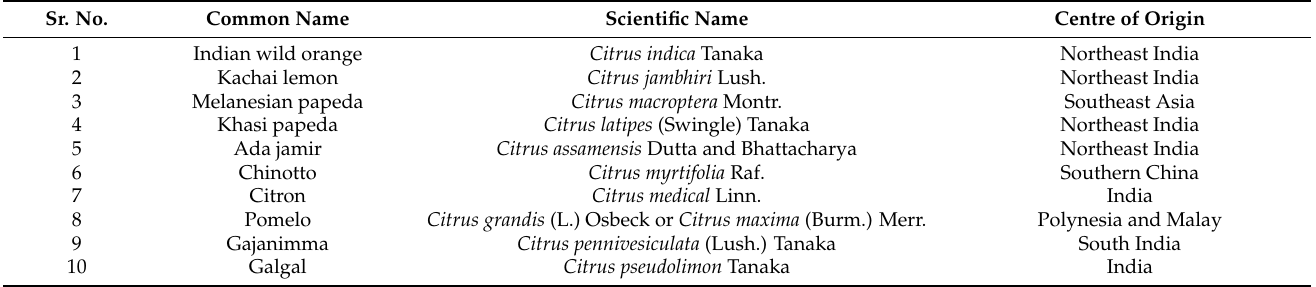
Citrus grandis (L.) Osbeck or Citrus maxima (Burm.)